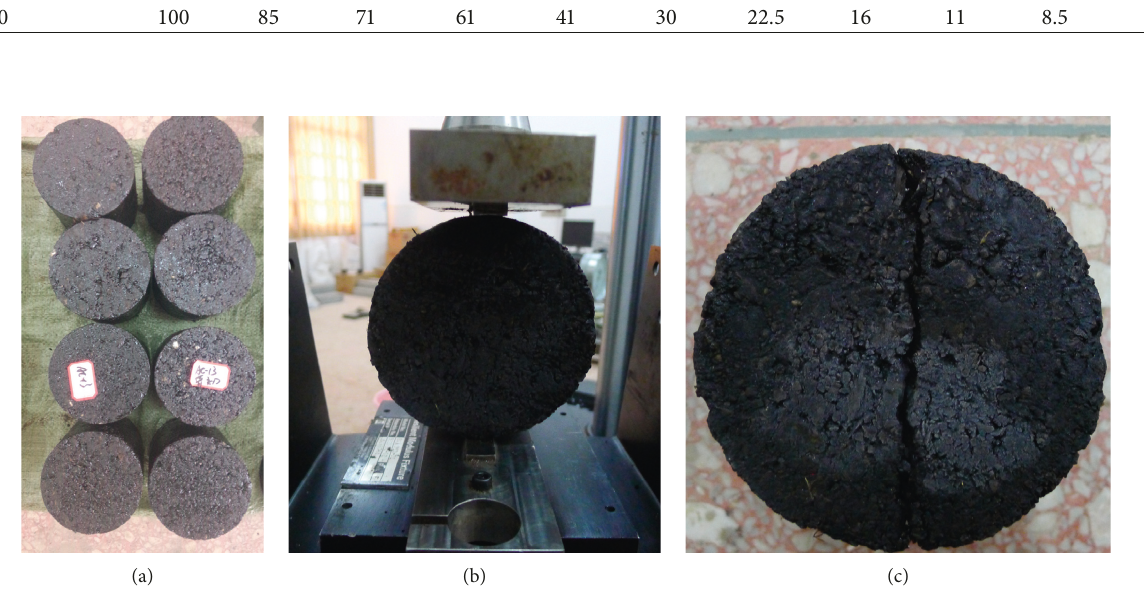
Figure 8: Splitting test. (a) AC-13 specimen. (b) Splitting test loading. (c) Failure mode of the splitting test.